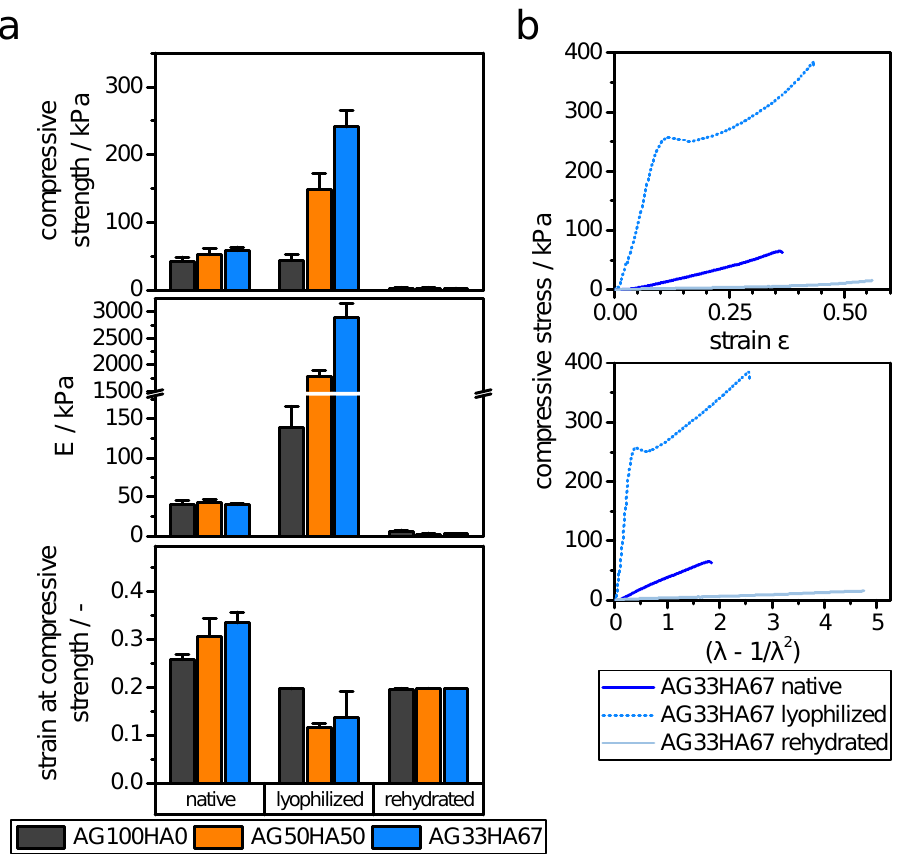
Figure 5. Compressive properties of native hydrogels, lyophilized, and rehydrated gels. ( a ) Compressive strength, elastic modulus E , and strain at compressive strength, derived from uni-axial unconfined compression ( n = 6). ( b ) Typical stress-strain and stress ( λ − 1/ λ 2 ) curves for AG33HA67